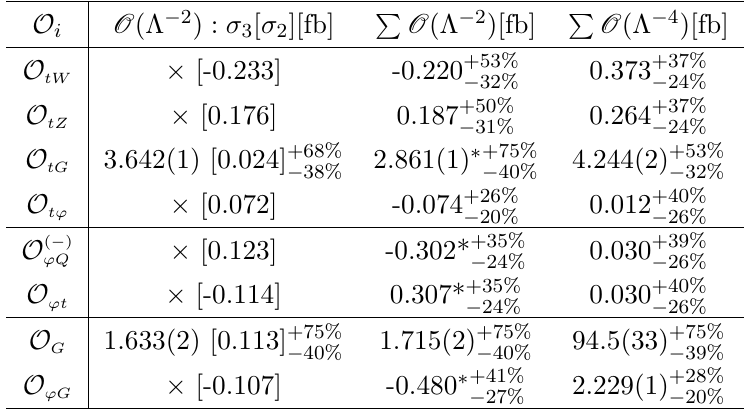
Table 10 . Same as table 8 but for the contributing operators. The × denotes zero cross-section. The asterisk indicates the operator receives non-negligible contributions at α s -orders lower than σ 2